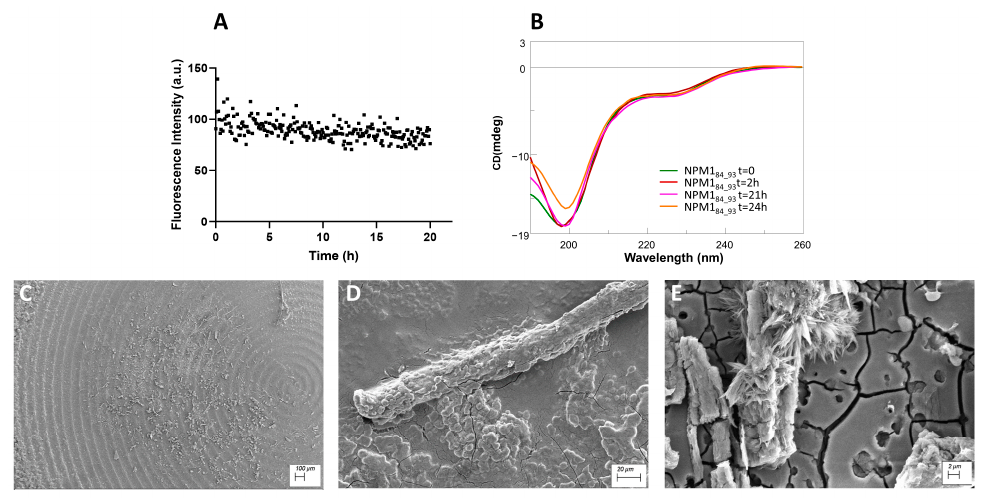
Figure 5. NPM1 84–93 characterization: ( A ) Time course of ThT fluorescence emission intensity; ( B ) CD